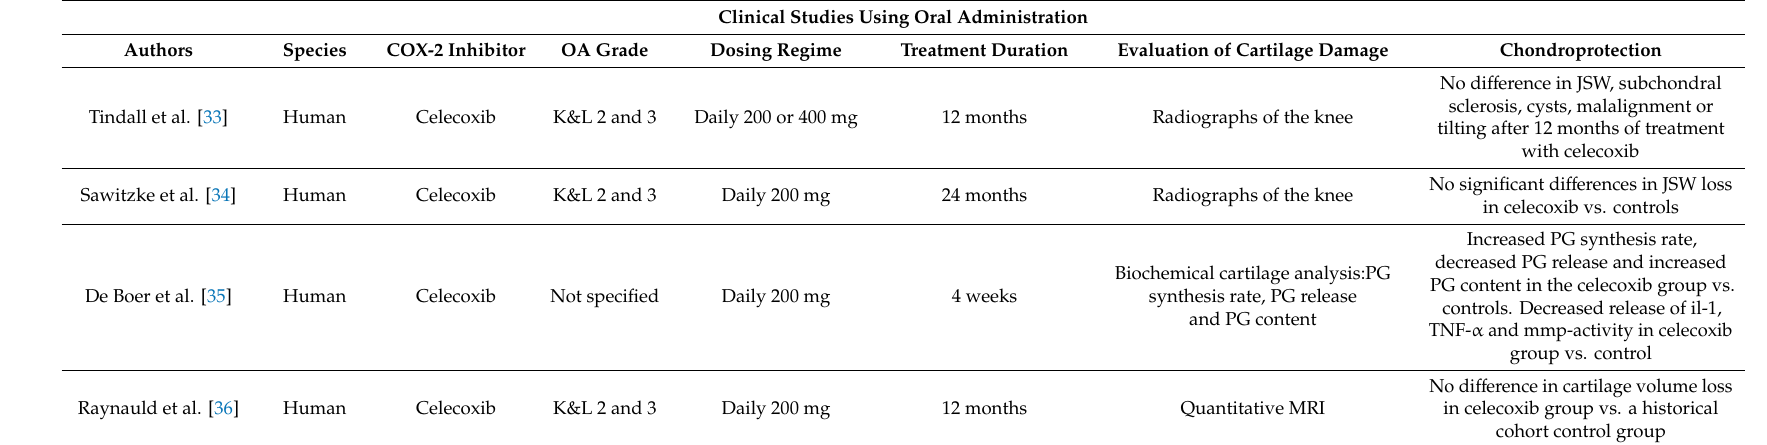
Table 3. The schematic overview of clinical studies investigating chondroprotective e ff ects of systemically administered selective COX-2